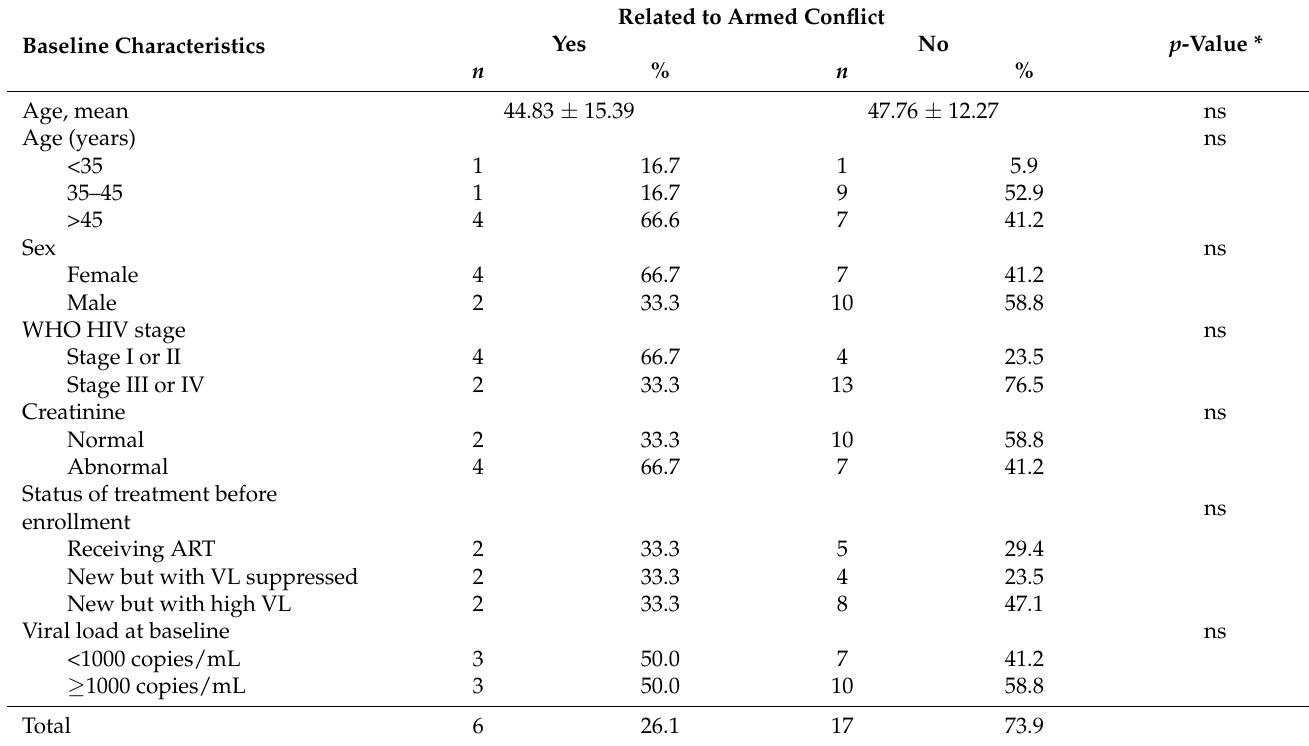
Table 4. Distribution of causes of death ( n =